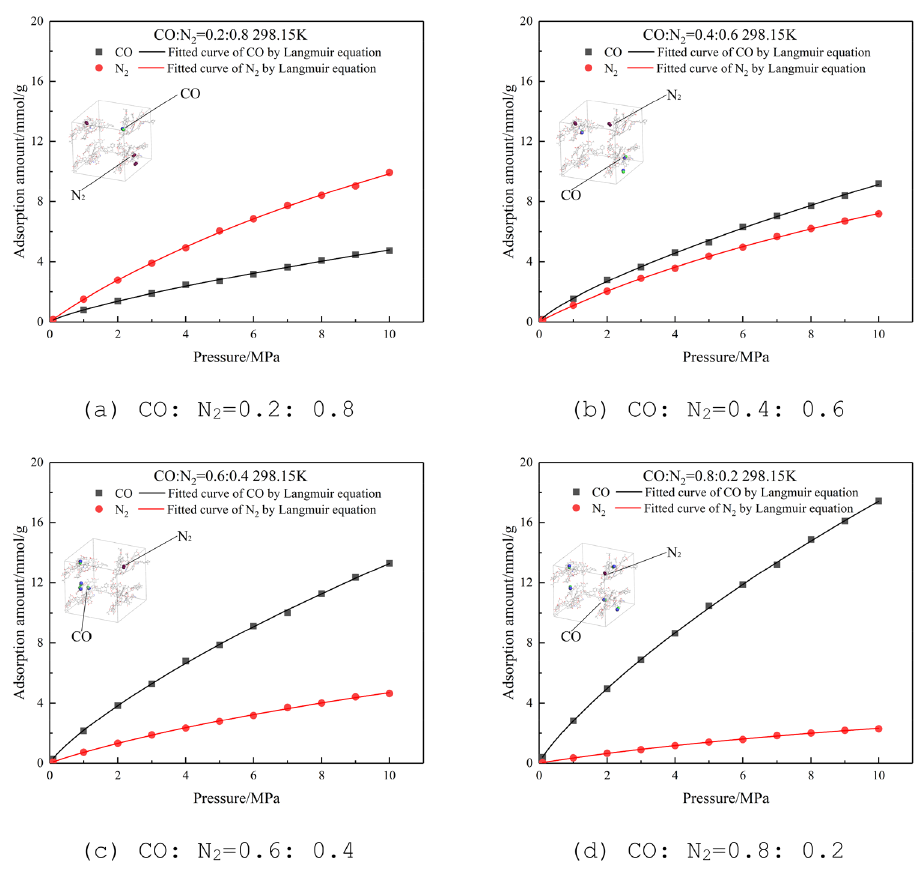
Figure 7. Adsorption isotherms of CO and N 2 at different molar ratios at 298.15